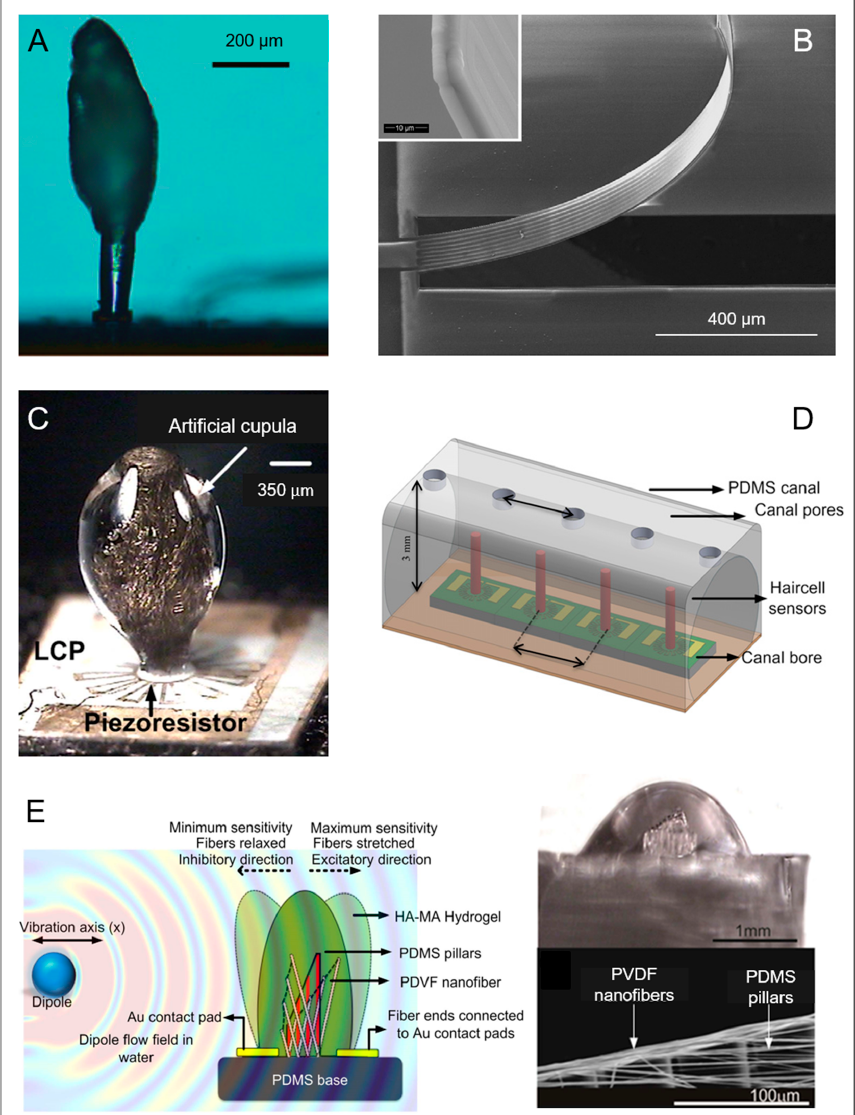
Figure 7. Artificial sensors with shape of cantilevers with domes. ( A ) Hydrogel cupula on hair sensor (reproduced from [36] with permission from The Royal Society of Chemistry). ( B ) Piezoresistive sensor with parylene coating (adapted from [123], Copyright 2012, with permission from Elsevier). ( C ) Hyaluronic acid methacrylic anhydride (HA-MA) based cupula (reproduced from [129], CC BY 4.0 [130]). ( D ) Artificial lateral line canal system (adapted from [126]. © IOP Publishing. Reproduced with permission. All rights reserved). ( E ) Piezoelectric sensor using the graded cilia principle (adapted from [124], CC BY 4.0 [130]). LCP: Liquid crystal polymer; PDMS: Polydimethylsiloxane; PVDF: Polyvinylidene